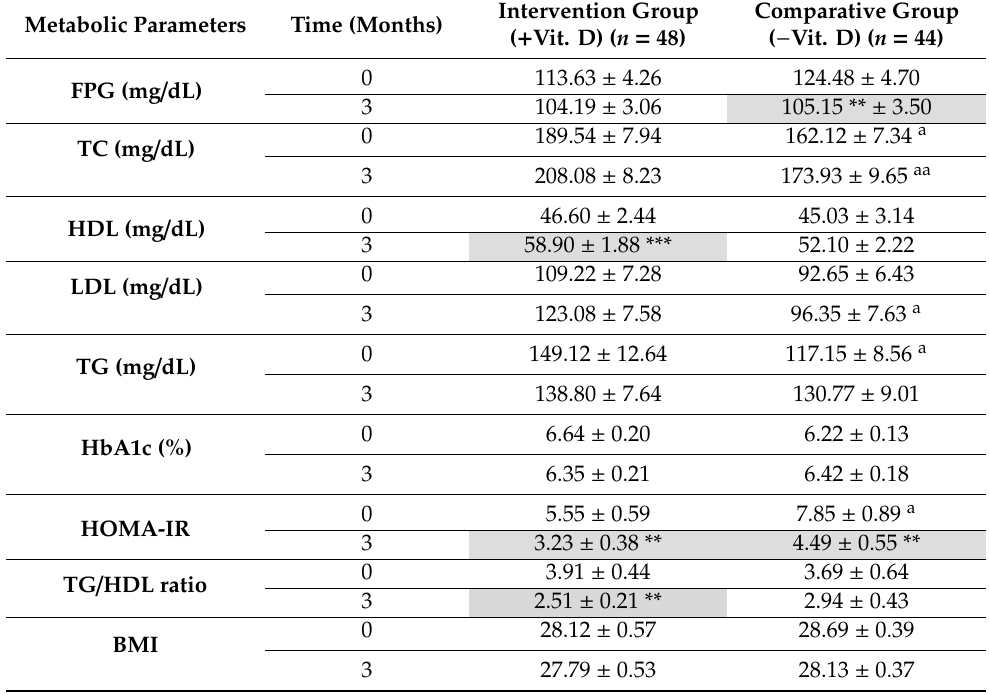
Table 1. Metabolic parameters of participants from the intervention group ( n = 48) and the comparative group ( n = 44) at baseline and after three-month vitamin D supplementation. Data are expressed as mean ± SEM. Intervention Group Metabolic Parameters Time (Months) ( + Vit. D) ( n =